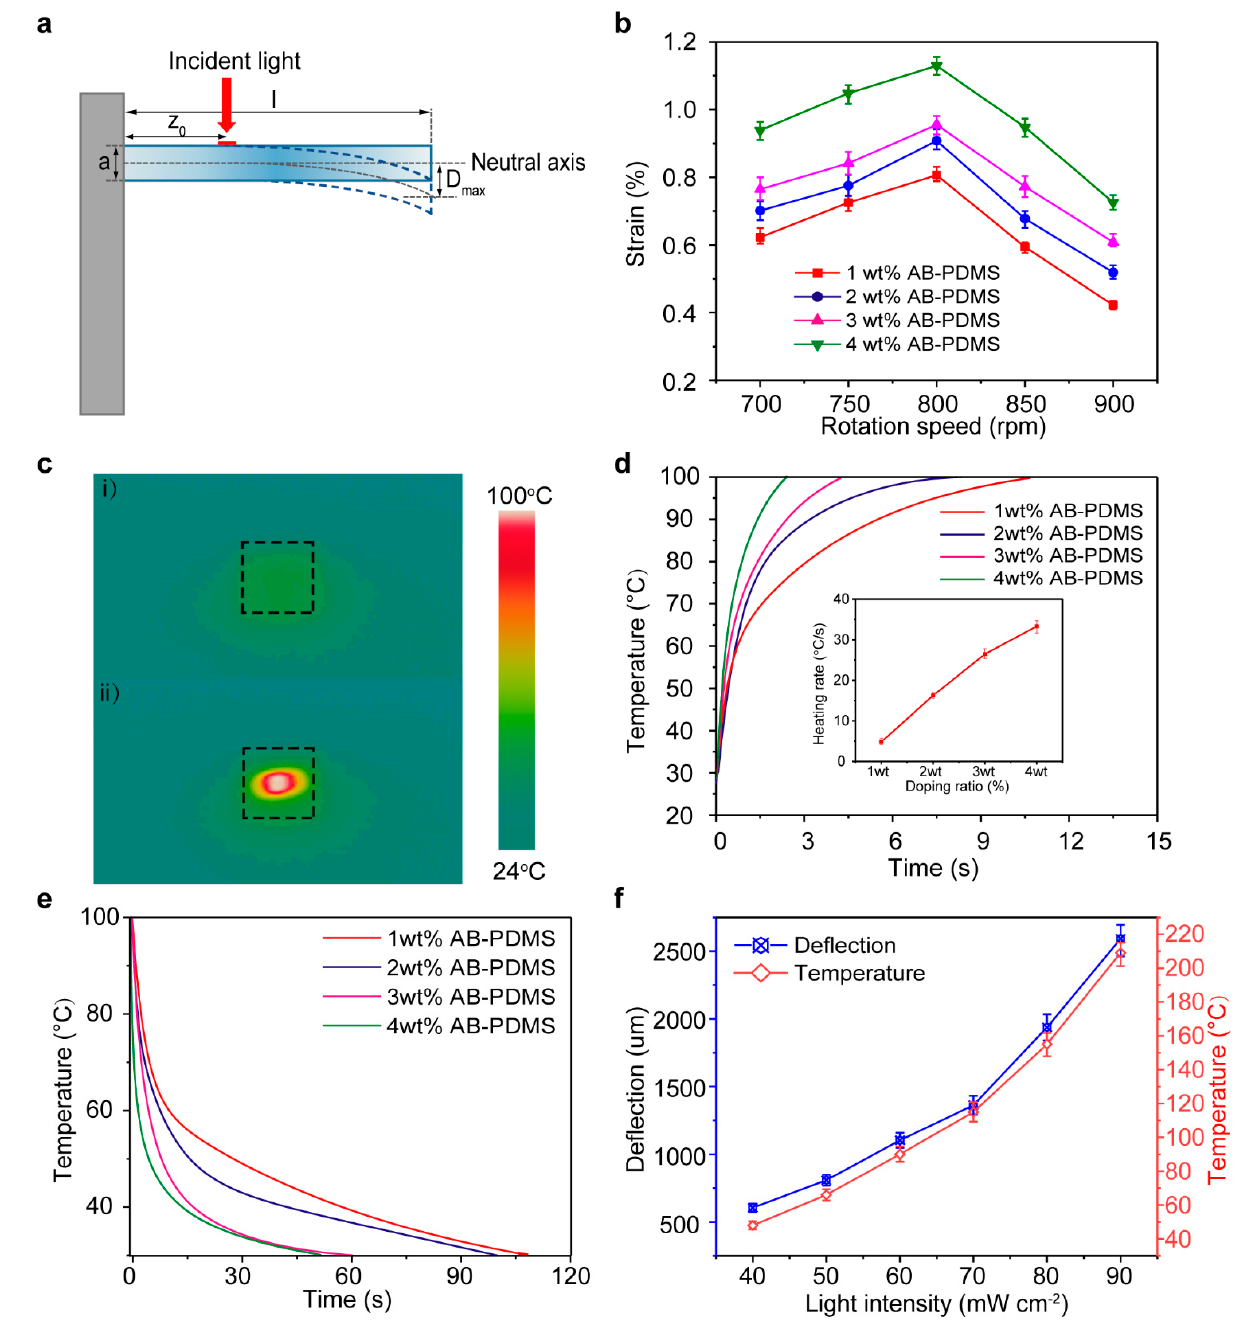
Figure 2. Properties of the bilayer photothermal actuation. ( a ) Schematic drawing for the measurements of the setup. ( b ) Deflection of the bilayer upon the photothermal actuation with different mixing ratios of AB and the rotation speed. ( c ) Thermal image of the bilayer (i) before and (ii) after the infrared irradiation. ( d ) Heating curve of the bilayer with various AB concentrations; the inset shows the heating rate has a linear relationship with the AB composition. ( e )The cooling curve of the actuator. ( f ) Deflection and the maximum temperature of the bilayer as a function of the near-infrared (NIR) light intensity.